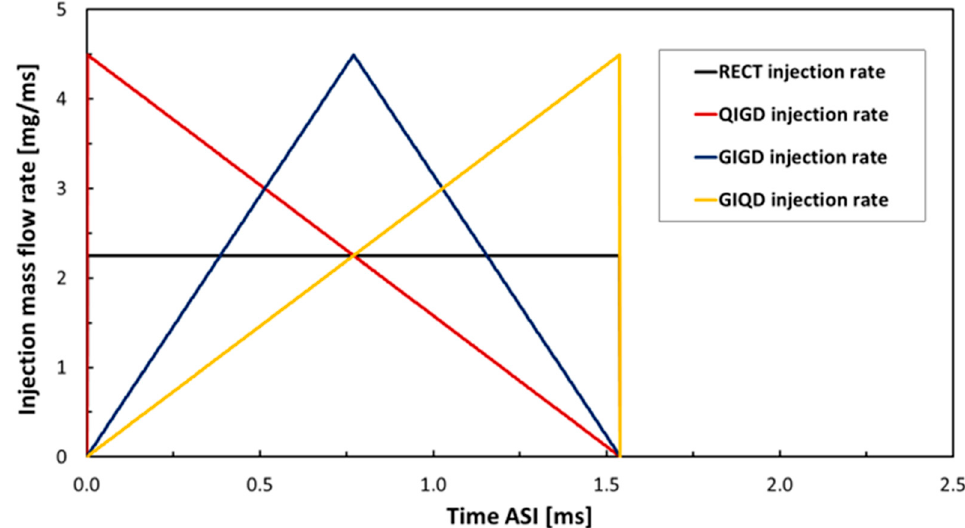
Figure 12. The varying shape of the fuel injection rate with a constant injection duration and fuel quantity. The rectangular injection rate (RECT), the Quick Increase Gradual Decrease injection rate (QIGD), the Gradual Increase Gradual Decrease injection rate (GIGD), and the Gradual Increase Quick Decrease injection rate (GIQD).